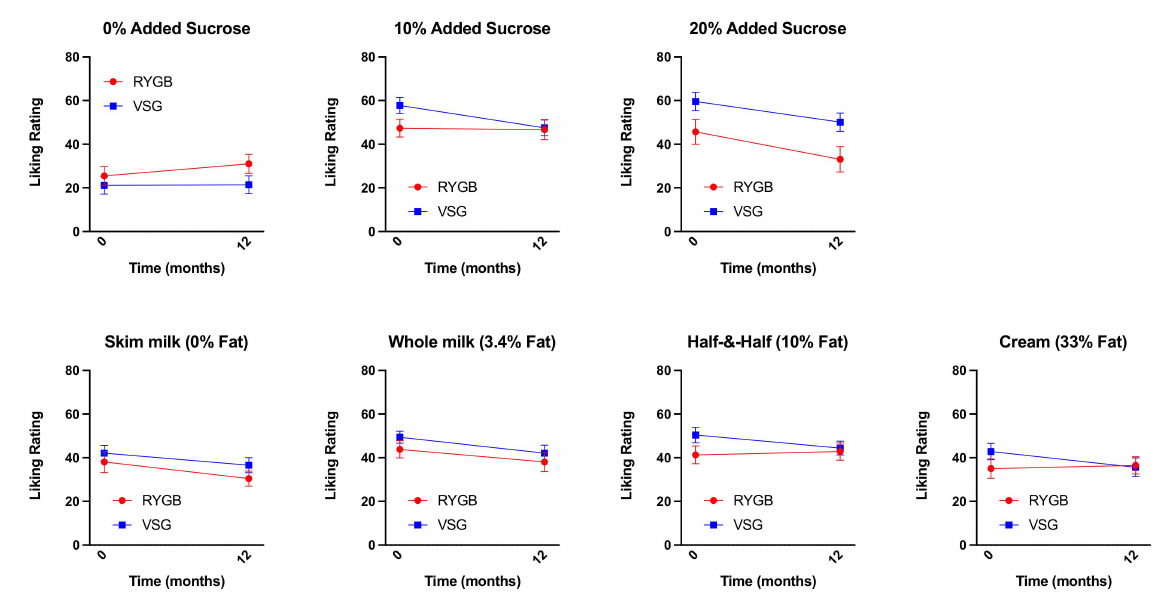
Figure 4. Mean ± SEM liking ratings for the mixtures varying in sucrose content (0%, 10%, and 20%) collapsed across all fat content and mixtures varying in fat content (0%, 3.4%, 10%, and 33%) collapsed across all sucrose concentrations at baseline (0 weeks) and one year following RYGB (red circles) and VSG (blue squares).